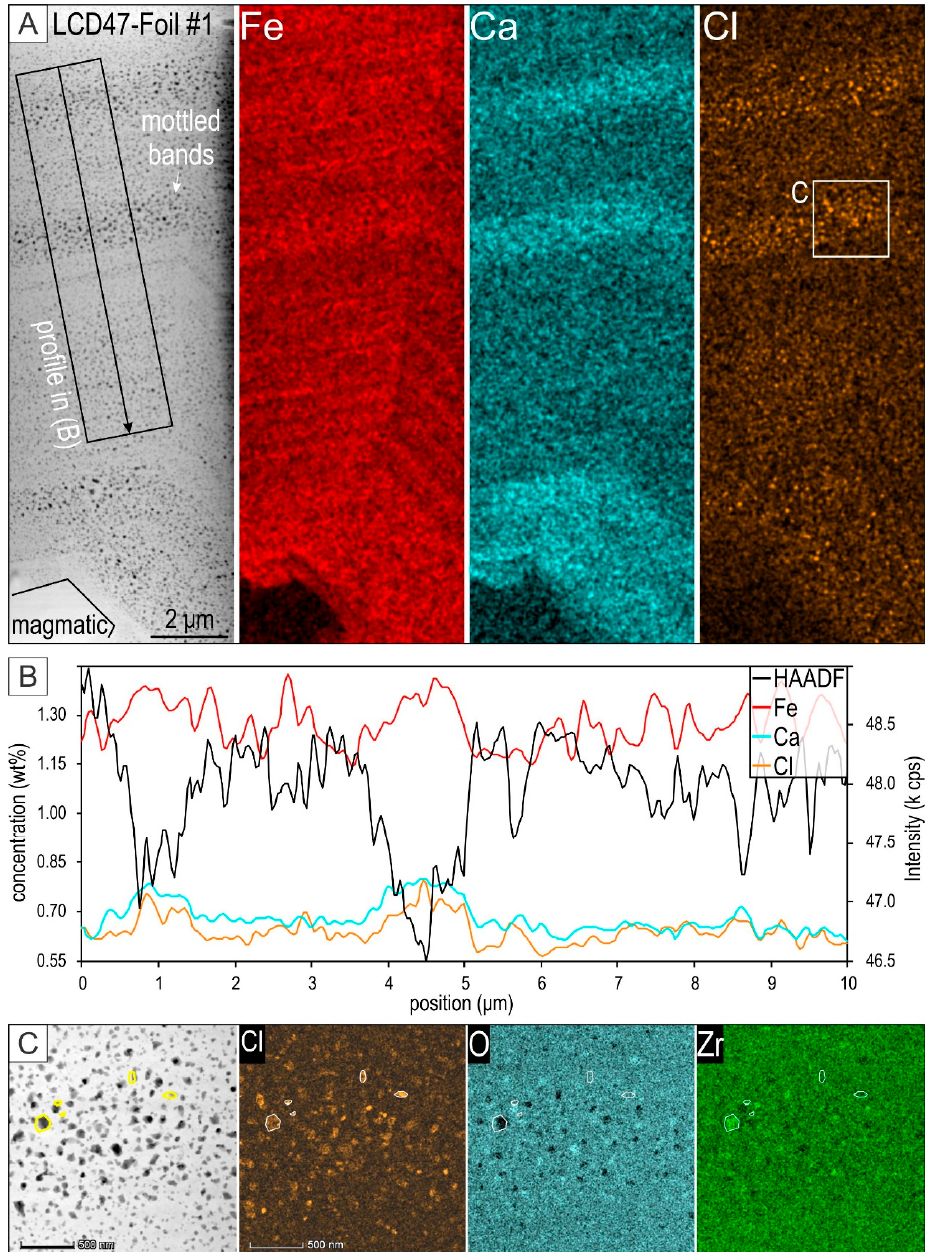
Figure 8. Trace element distributions in OD distal zircon from Foil #1. ( A ) HAADF STEM image and EDS STEM maps for Fe, Ca, and Cl showing oscillatory zoning and mottled textures. Enrichment in Ca and Cl occurred throughout the mottled bands. ( B ) Profile across the oscillatory zoning displayed positive correlation between Ca and Cl across the most intensively mottled bands. Iron distributions broadly correlated with Ca and Cl across the same bands but showed small-amplitude variation reflecting the finest-scale oscillatory banding. The HAADF intensity signal showed a negative correlation with the Ca- and Cl-enriched bands. ( C ) Image and EDS STEM maps (extended maps in Supplementary Materials C, Figure S3) of a Cl-rich area as marked in ( A ). Note the inconsistency in correlation between Cl with O and Zr (compare the areas outlined on the figure), e.g., high Zr and low-O where Cl-enrichment is moderate, but no changes for O and Zr for nanodomains with the highest Cl content.